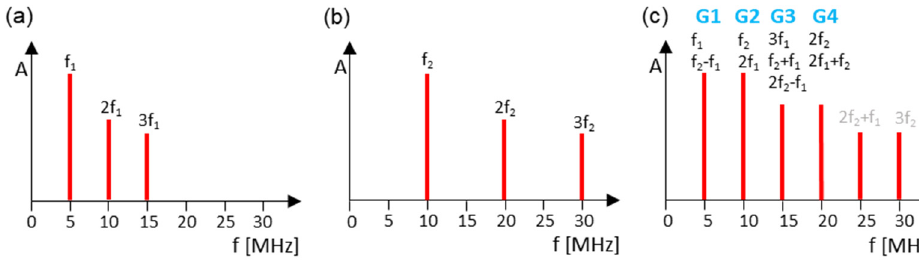
Figure 4. Grouping spectra: ( a ) f 1 = 5 MHz; ( b ) f 2 = 10 MHz; ( c ) f 1 = 5 MHz and f 2 = 10 MHz.